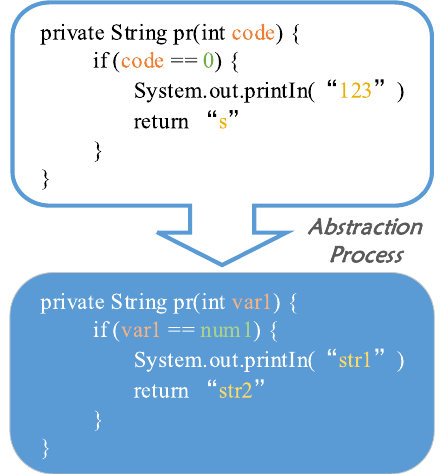
Fig. 3 Example of abstraction